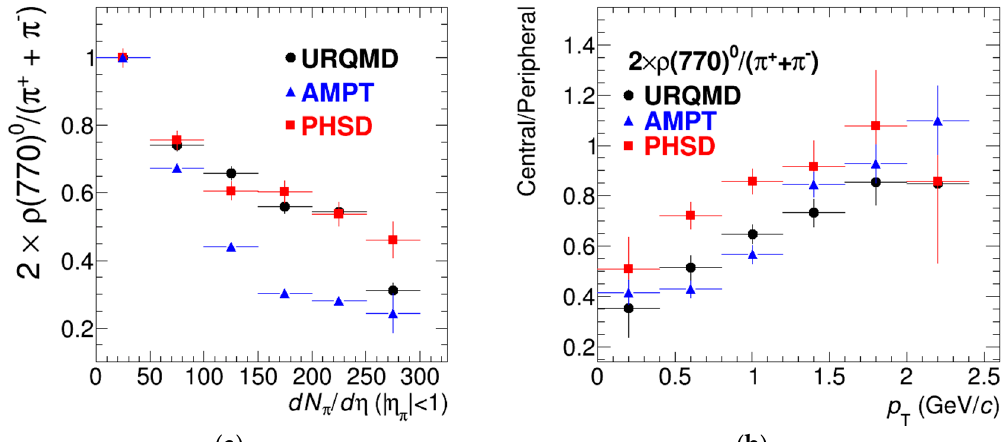
Figure 5. Ratios ρ (770) 0 / π predicted by UrQMD [11], PHSD [12] and AMPT [13] event generators in Au+Au collisions at √ 𝑠 𝑁𝑁 = 11 GeV. The ρ (770) 0 / π ratios normalized to unity in most peripheral collisions are shown as a function of the final state charged ‐ particle multiplicity ( a ) and the ( ρ (770) 0 / π ) central /( ρ (770) 0 / π ) peripheral double ratio is shown as a function of the transverse particle momentum ( b ).